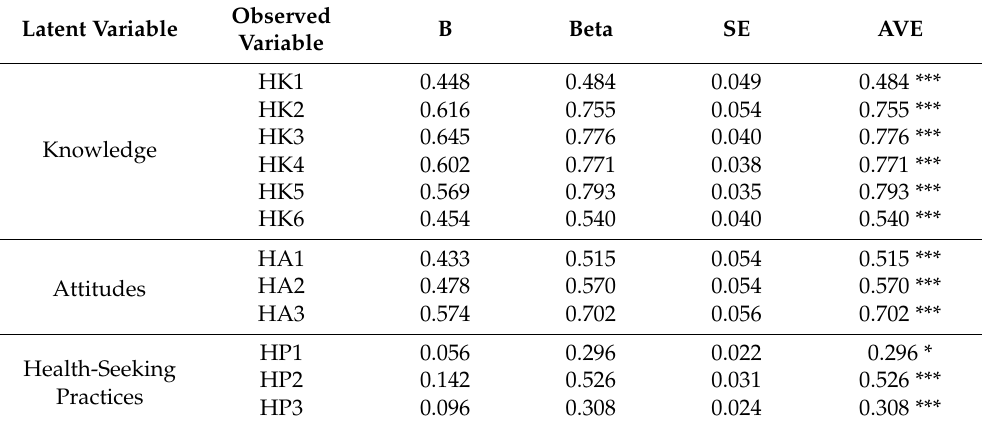
Table 4. Comparison of results for goodness-of-fit indices for the basic and final models of healthcare